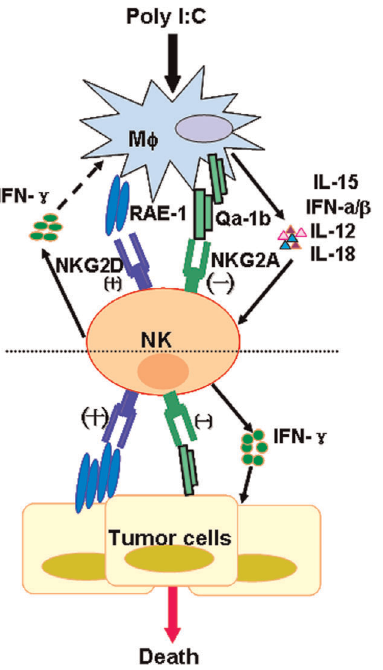
Figure 8. Working model of innate recognition-mediated interaction between NK cells and macrophages during anti- tumor immune response. As a response to stimulation from TLR3 ligand poly I:C, macrophages up-express surface RAE-1 (NKG2D ligand) and produce soluble IL-12, IL-15, and IFN- b . RAE-1 on surface of macrophages and their cytokines will strongly activate NK cells to produce IFN- c and up-expression of NKG2D. IFN- c produced by NK cells will stimulate macrophages in feedback. NK cells after activation will directly attack tumor cells by recognizing tumor’s RAE-1 and indirectly arrest tumor growth by secreting IFN- c . At the same time, poly I:C- induced up-regulation of NKG2A ligand Qa-1 protects macrophages themselves from cytolysis by NK cells in order to keep the positive feedback loop in the anti-tumor immune response.